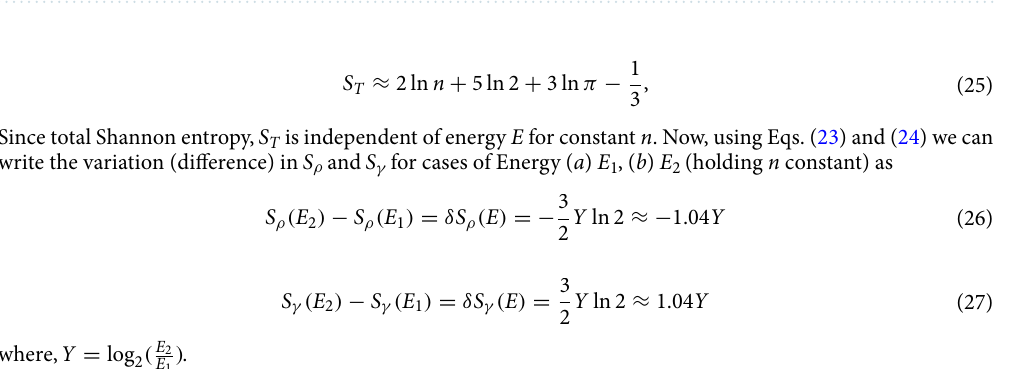
Table 2. The analytical and numerical values of the variation (difference) of Shannon entropy in both position space and momentum space for cases of atomic number ( a ) Z 1 , ( b ) Z 2